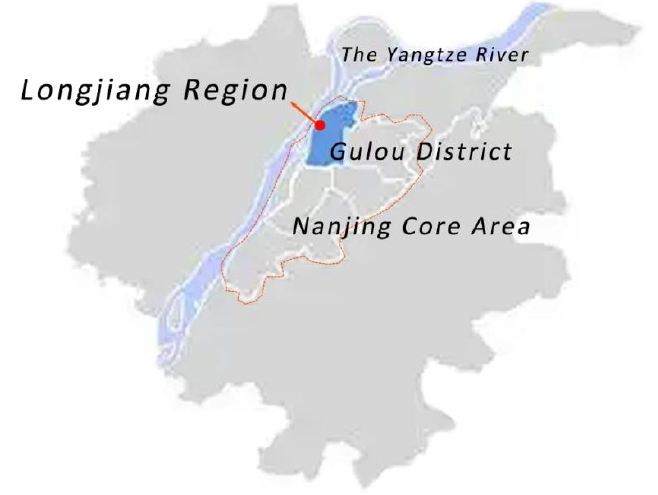
Figure 1. Location of Longjiang Region, Nanjing, China.